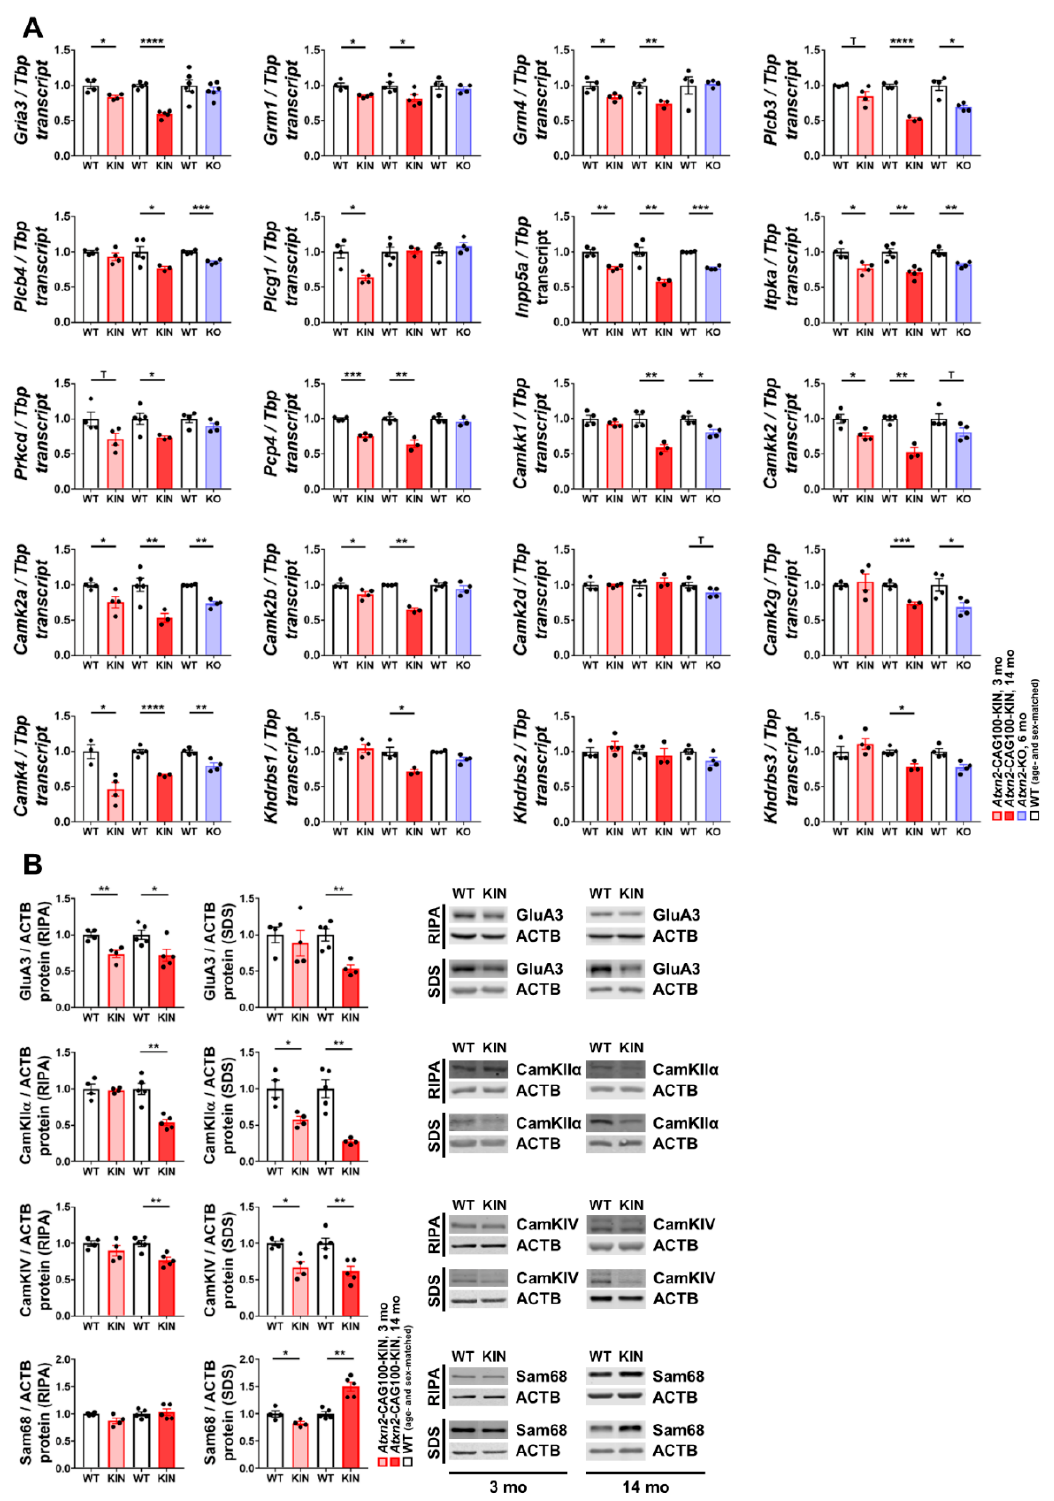
Figure 4. Expression analyses of Ca 2 + associated subcellular signaling pathways in Atxn2 -CAG100-KIN cerebellum throughout disease course. ( A ) Transcript levels of cytoplasmic IP 3 metabolism components ( Gria3, Grm1 , Grm4 , Plcb3 , Plcb4 , Plcg1 , Inpp5a, Itpka, Prkcd ), Ca 2 + -CaM signaling components ( Pcp4 , Camkk1 , Camkk2 , Camk2a , Camk2b , Camk2d , Camk2g , Camk4 ) and downstream CaMKIV targets ( Khdrbs1-3 ) were quantified by RT-qPCR in Atxn2 -KO (blue bars) and Atxn2 -CAG100-KIN mouse cerebellum at pre-onset (pink bars) and terminal (red bars) disease stages; ( B ) Protein levels of GluA3, CaMKII α , CaMKIV and Sam68 in soluble (RIPA) and insoluble (SDS)